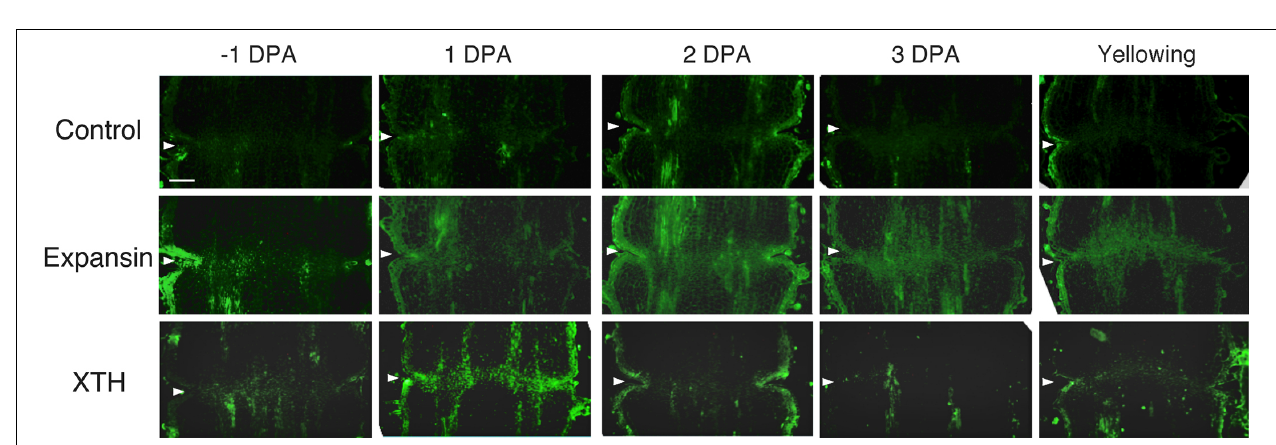
FIGURE 4 | Immunolocalization of expansin and XTH epitopes in the AZs of (cid:0) 1 DPA to 3 DPA pollinated flower pedicels. Pollination allowed the pedicel and AZ to enlarge and strengthen in adhesion. Longitudinal sections of